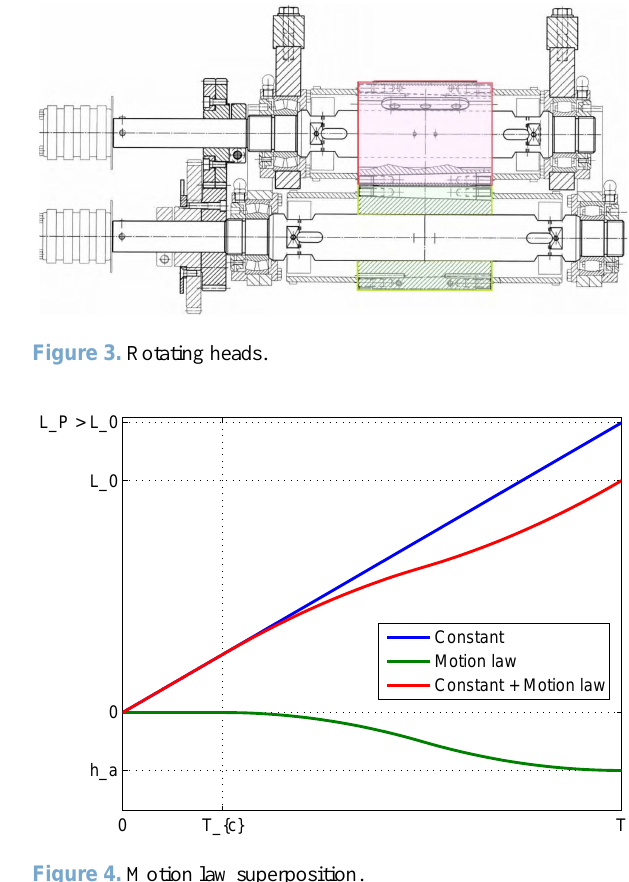
Figure 4. Motion law